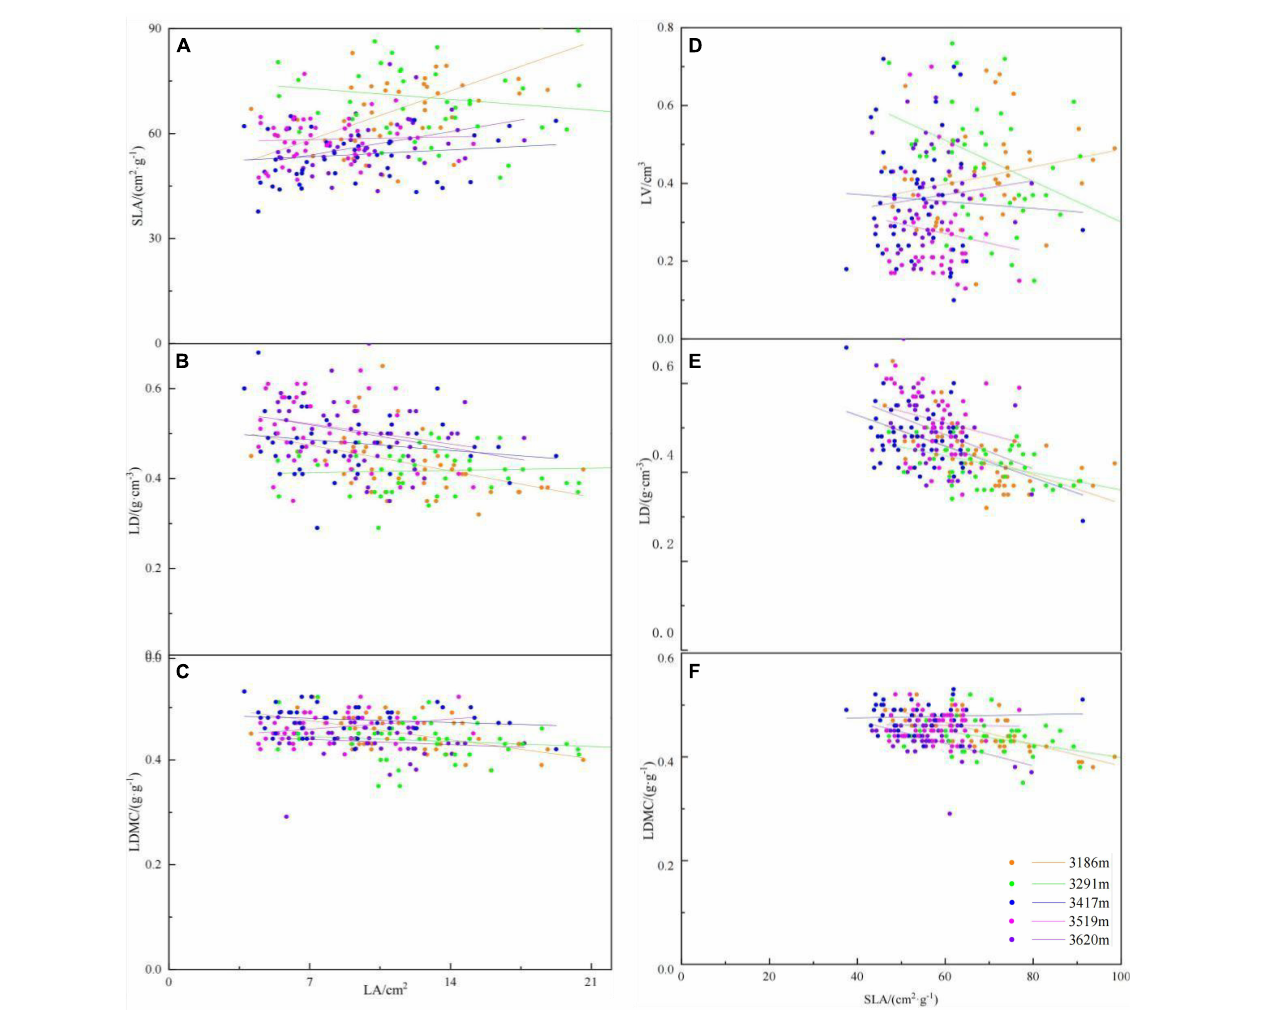
FIGURE 4 | The scaling relationships between leaf functional traits at different altitudinal gradient. (A) The scaling relationship between leaf area (LA) and specific leaf area (SLA); (B) the scaling relationship between leaf area (LA) and leaf density (LD); (C) the scaling relationship between leaf area (LA) and leaf dry-matter content (LDMC); (D) the scaling relationship between specific leaf area (SLA) and leaf volume (LV); (E) the scaling relationship between specific leaf area (SLA) and leaf density (LD); and (F) the scaling relationship between specific leaf area (SLA) and leaf dry-matter content